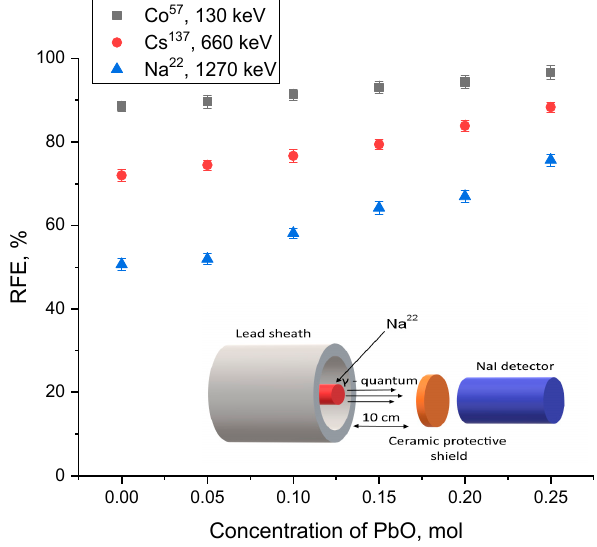
Figure 12. Results of determining the efficiency of gamma radiation intensity reduction when synthesized ceramics are used as shielding materials (the inset to the figure shows a schematic representation of experiments on shielding gamma radiation).